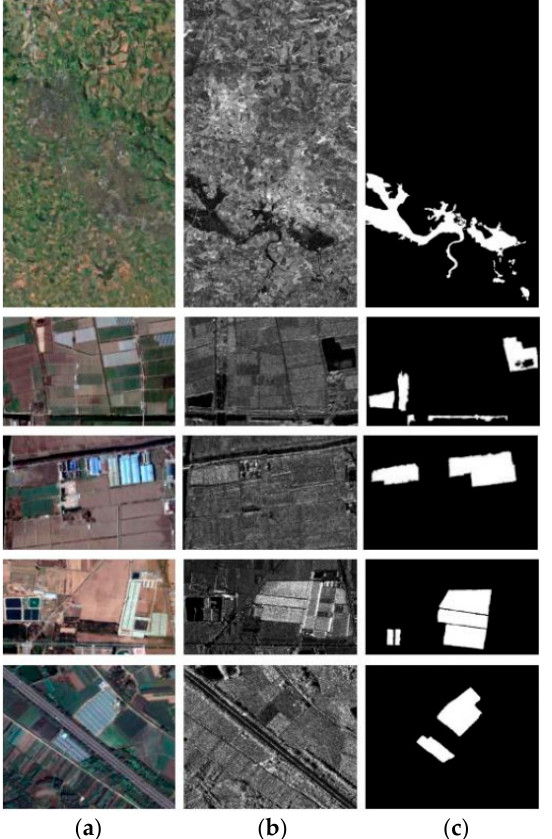
Figure 9. Heterogeneous optical/SAR data sets. ( a ) Optical image. ( b ) SAR image. ( c ) Reference change map.